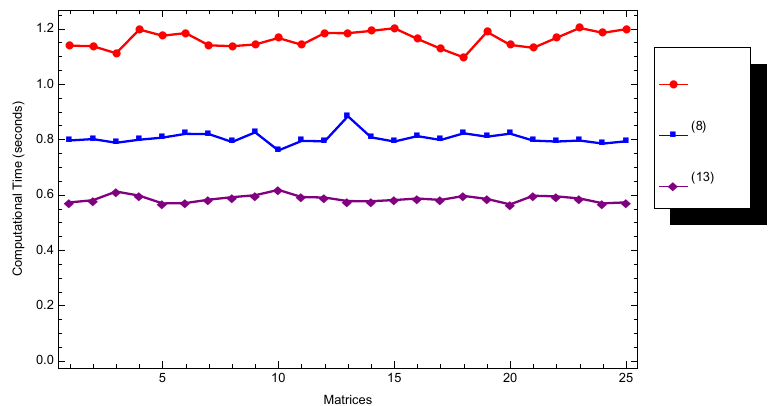
Figure 3. The CPU time required for different matrices in Test Problem